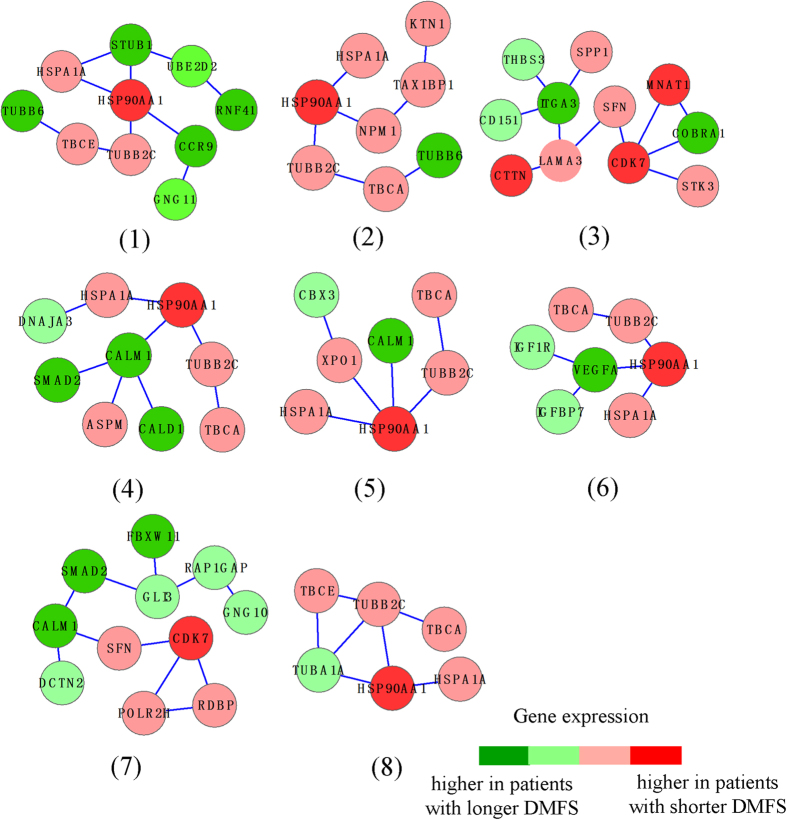
SPNs discovered in the P-high group, i.e. P-high SPNs.There are 8 SPNs discovered in the high proliferation (P-high) group. P-high SPNs contain important genes, like the HSP90AA1, CALM1, VEGFA, etc. Genes are color coded (i.e. red/green: genes that are overexpressed/underexpressed in patients with shorter DMFS). In the color bar, deep green means that log2(fold change) <0, ligh green or light red represents that 0< fold change <1, while deep red means that log2(fold change) >0. Details can be found in Results.